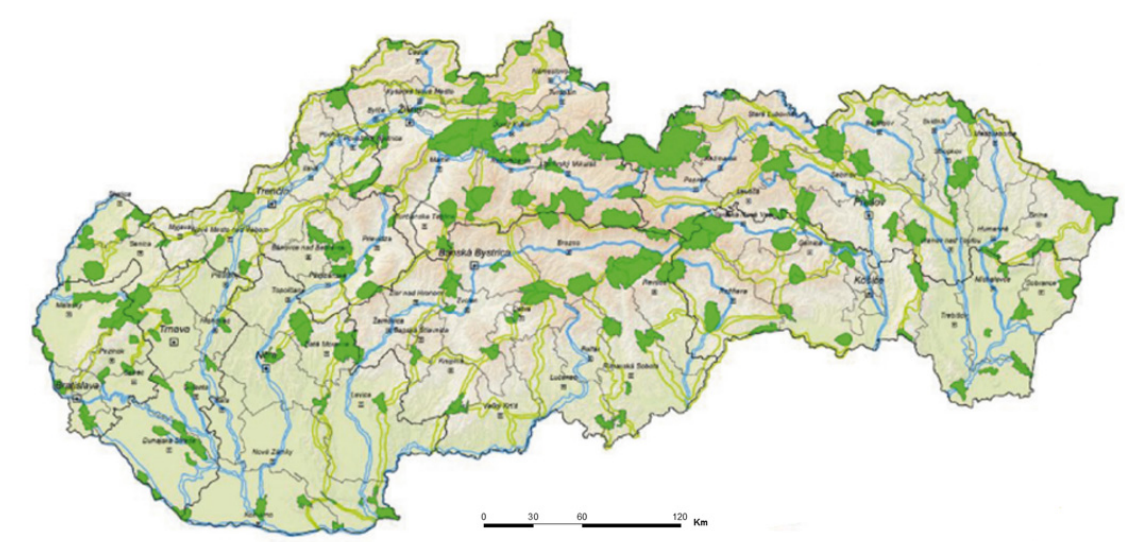
Figure 10. A similar ecological network: the Territorial System of Ecological Stability in Slovakia, containing supra-regional bio-centers, hydric bio-corridors, terrestrial bio-corridors (processed based on [45]).